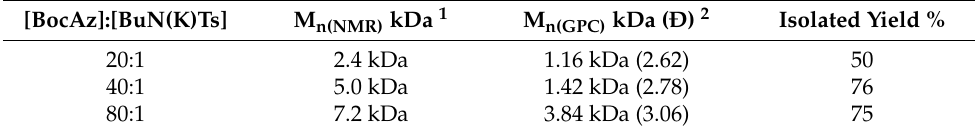
Ð estimated using a GPC calibrated on PMMA standards.